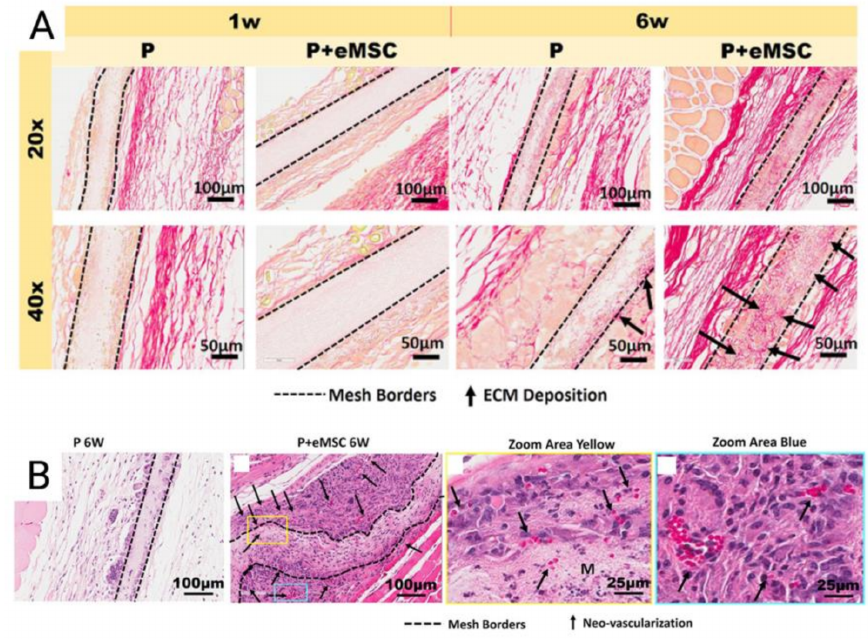
Figure 6. ( A ) Explanted Poly-L-lactide-co- ε -caprolactone (PLCL) nanomeshes with and without endometrial mesenchymal stem/stromal cells (eMSC) showing Picro-Sirius red staining of collagen, at 1 and 6 weeks explantation; ( B ) 6-week nanomesh explants with and without eMSC demonstrating improved neovascularisation (black arrows) within mesh area (yellow) with eMSC compared to without. Reprinted with permission from Mukherjee et al. (2020) [66]. Copyright: © 2021 by the